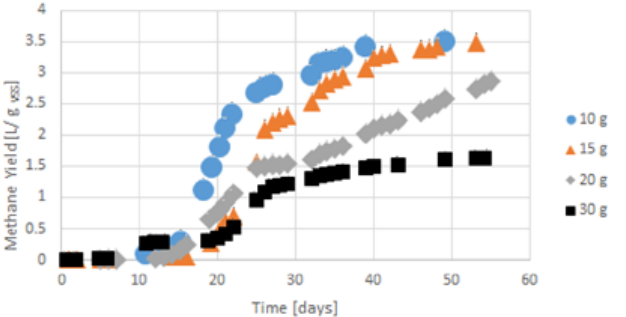
Figure 8. Accumulated methane production yield in the first 20 days for gelatine concentration from 10 g VSS/L to 30 g VSS/L.